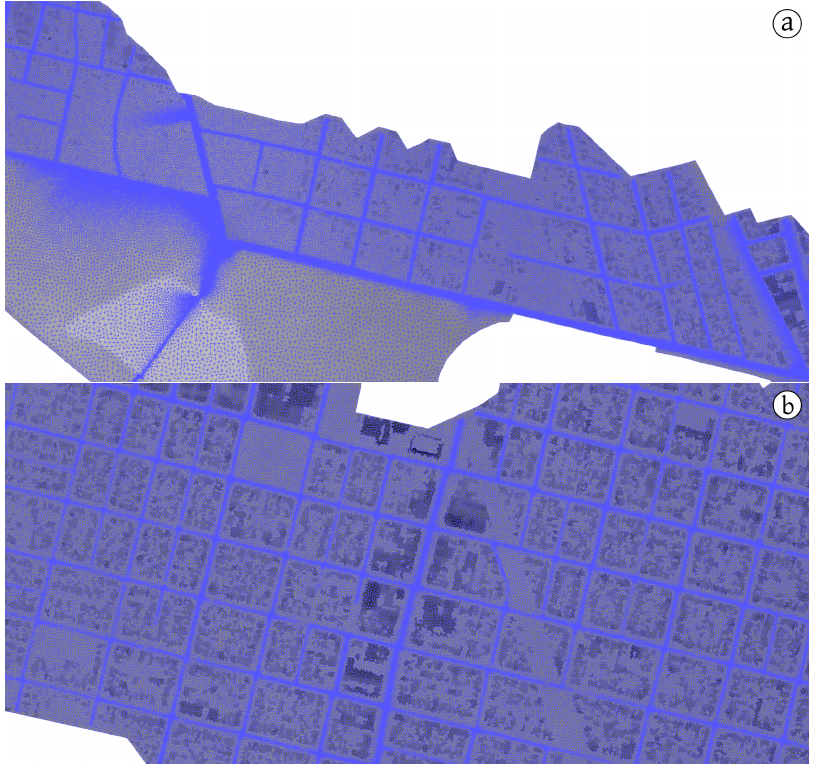
Figure 16. Case 3: Detail of the unstructured triangular and locally refined computational mesh ( a , b